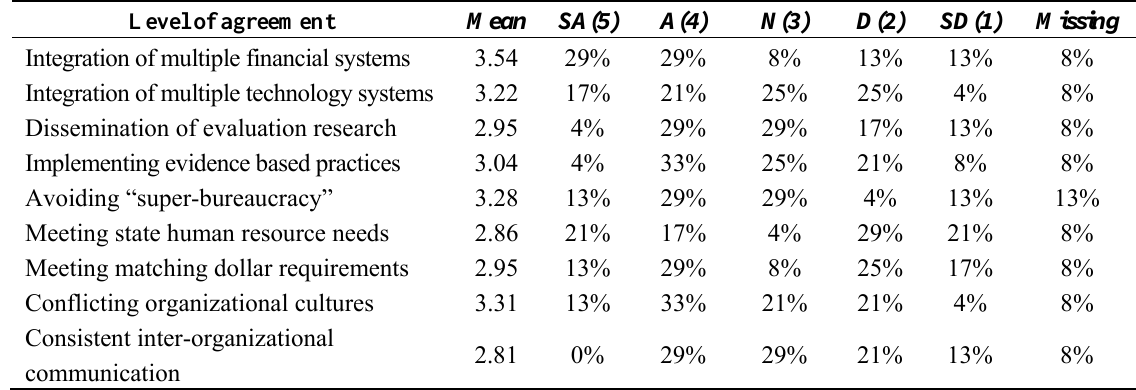
Table 2. Respondents rating that challenge is present in partnership (N =